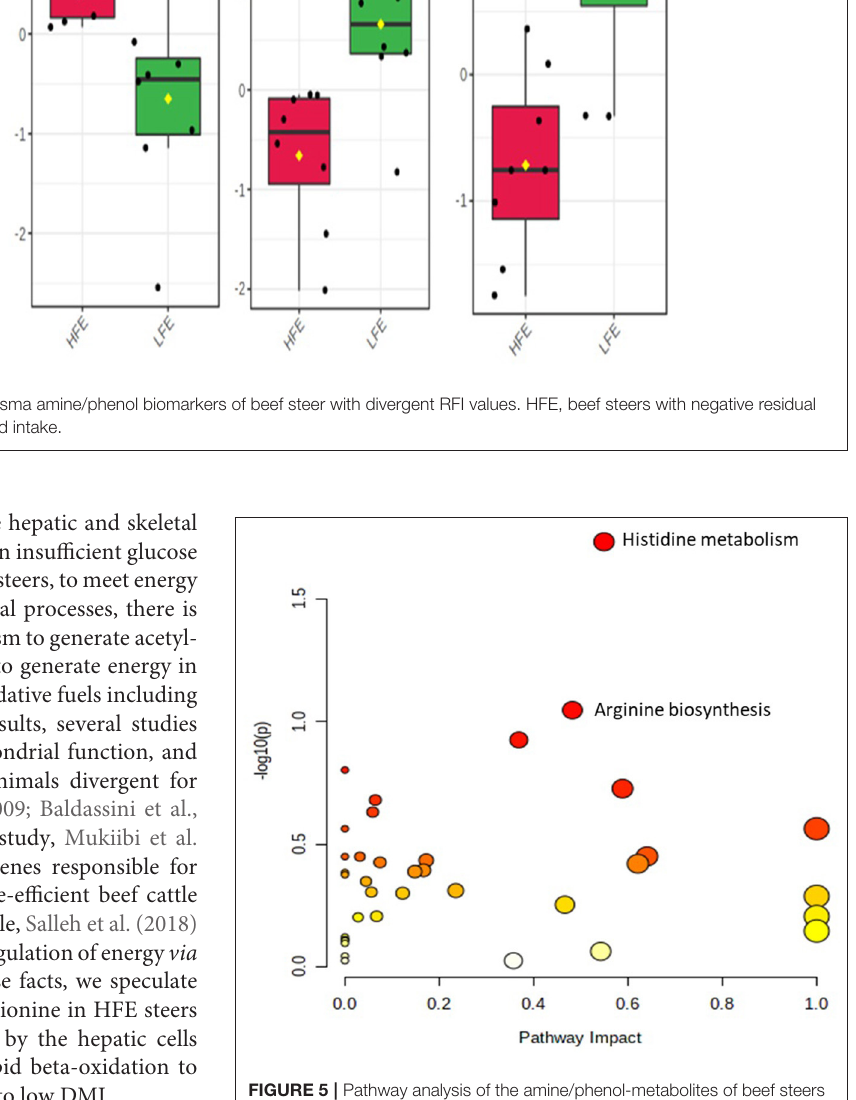
FIGURE 5 | Pathway analysis of the amine/phenol-metabolites of beef steers with divergent RFI values. Metabolic pathways with –log10(P) ≥ 1.0 (equivalent to P ≤ 0.10) are enriched in HFE steers, relative to LFE. HFE, beef steers with negative residual feed intake; LFE, beef steers with positive residual feed